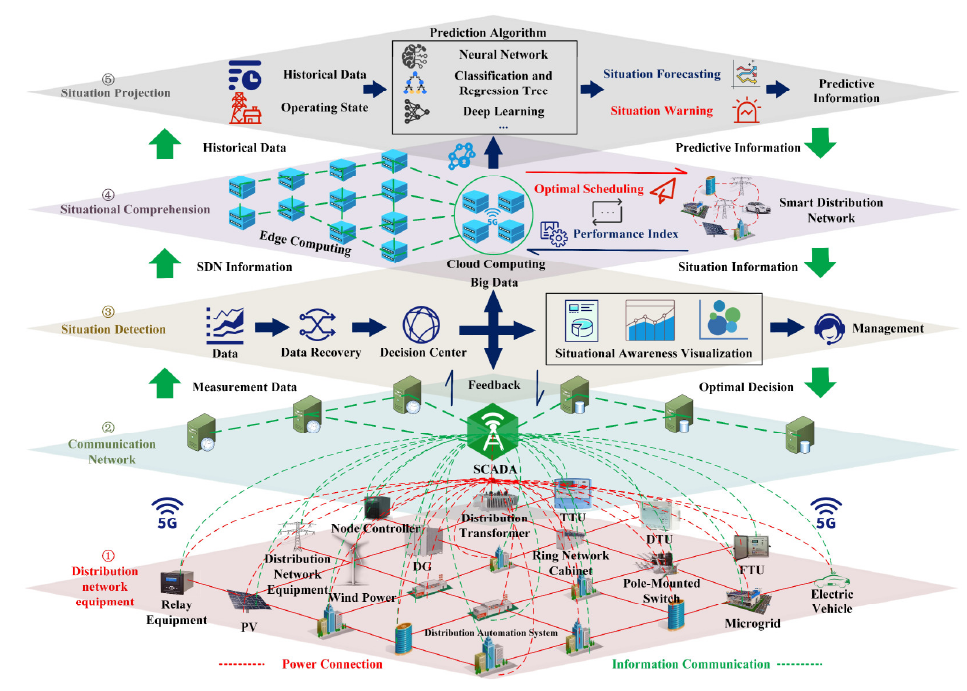
Figure 1. A 5-layer comprehensive framework of SDN